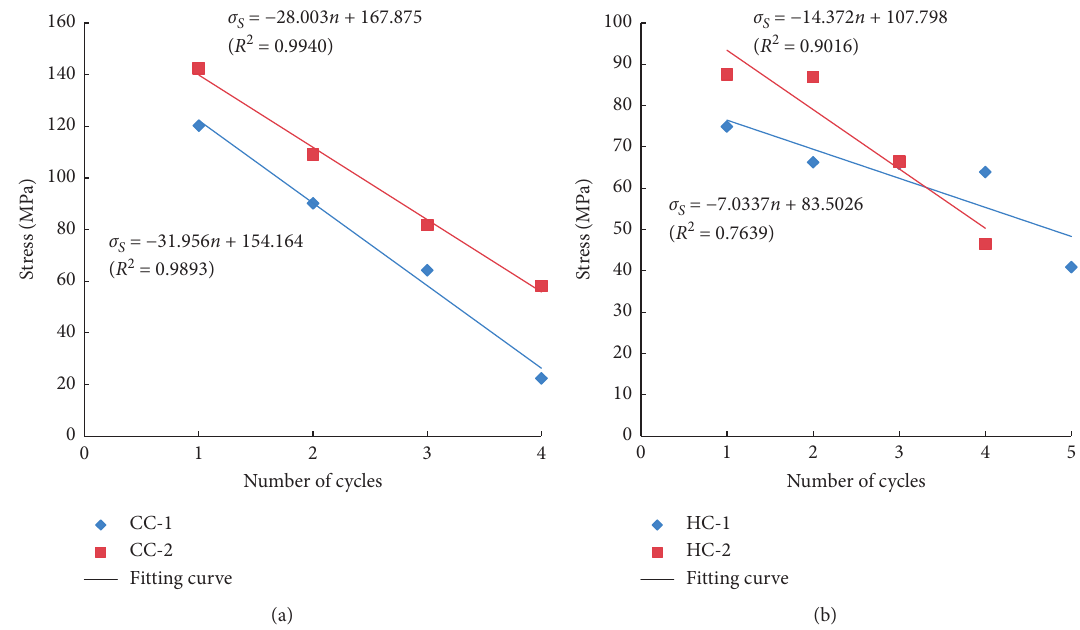
Figure 6: Relation between peak stress and the number of cyclic impacts. (a) Mortar. (b) Concrete.